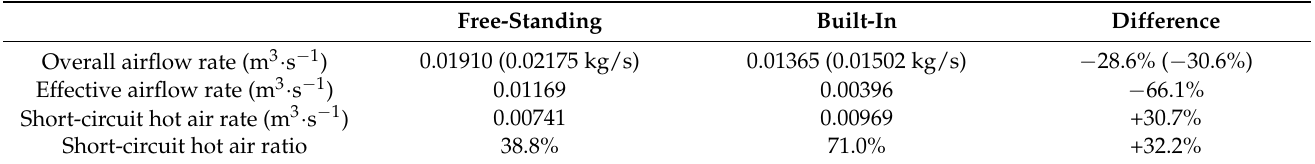
Table 4. Simulation results of the airflow rate for two configurations. Free-Standing Built-In Difference Free-Standing BUILT-IN